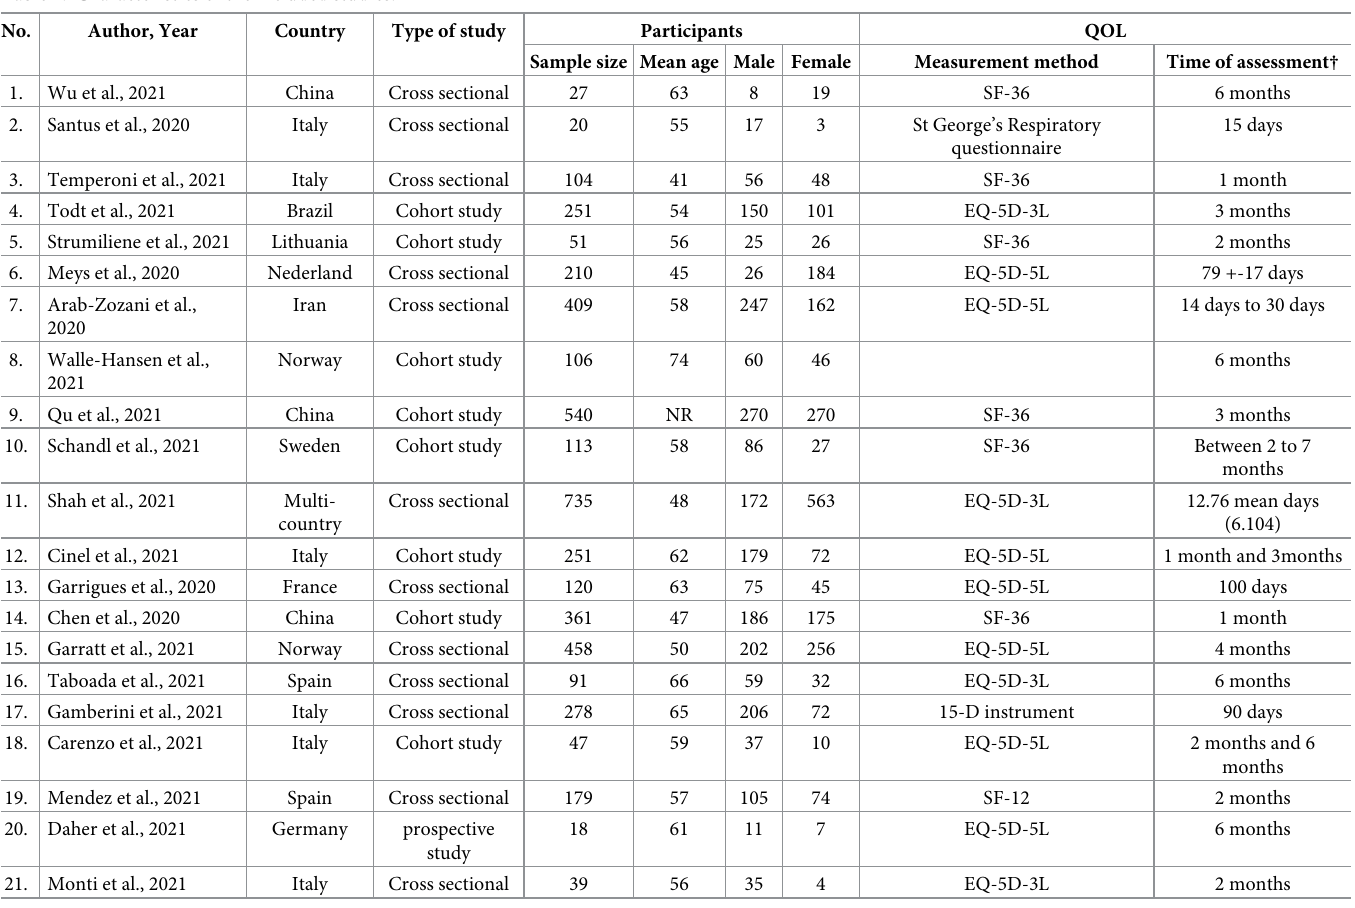
Table 1. Characteristics of the included